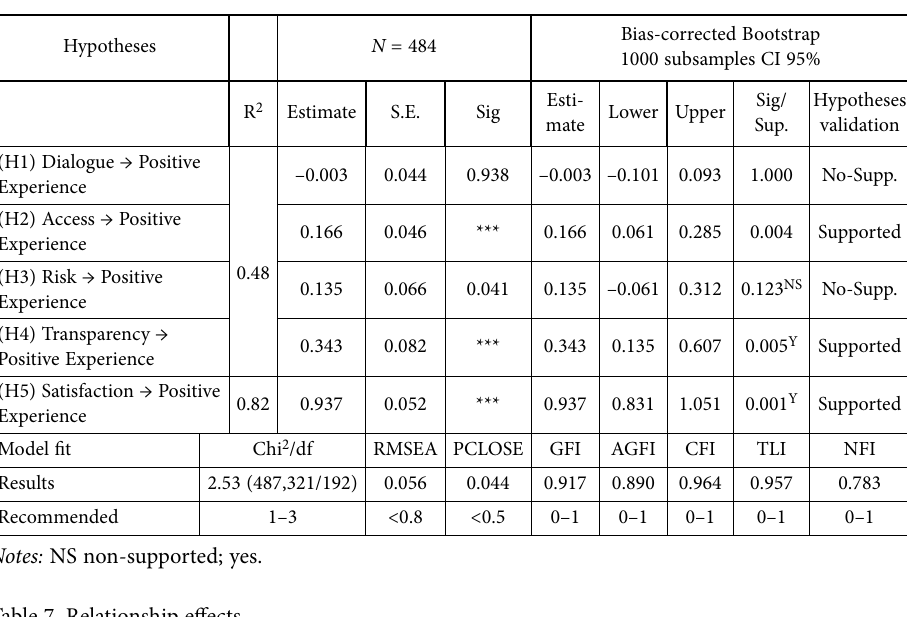
Table 6. SEM-results and null-hypothesis significance